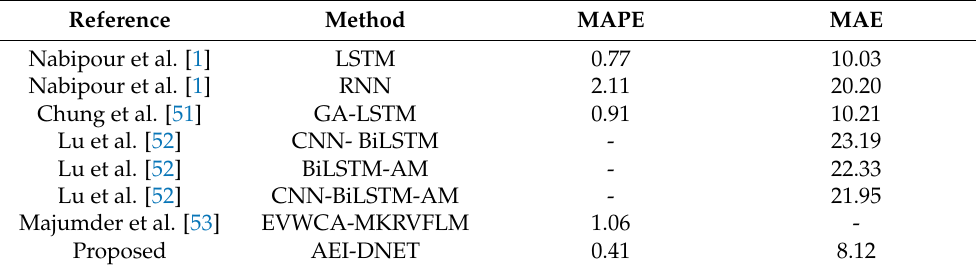
Table 20. Comparison with state-of-the-art